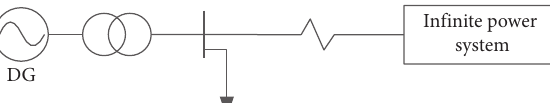
Figure 12: Single-machine (DG) infinite power system.